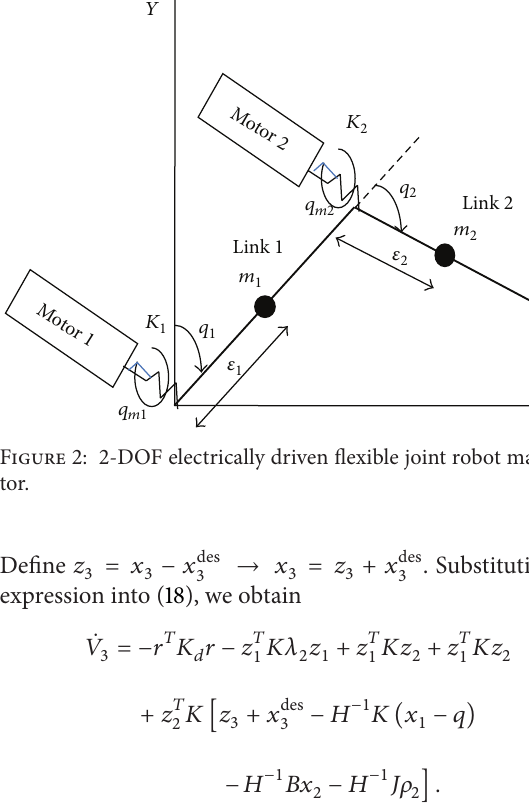
Table 1: Values of system parameters used in numerical simulation.